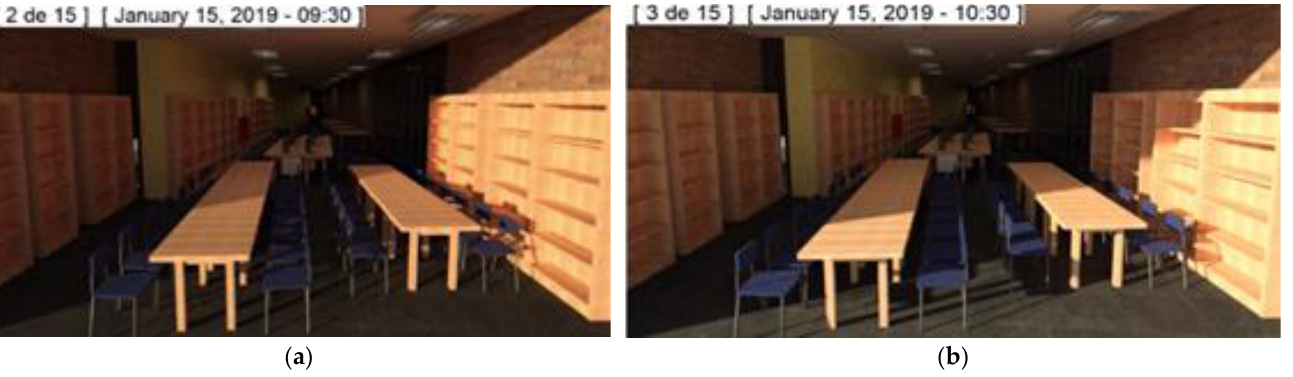
Figure 7. Two frames from one of the daylight simulation videos, showing the evolution of the sun’s rays inside the library’s study room through the 15th of January.